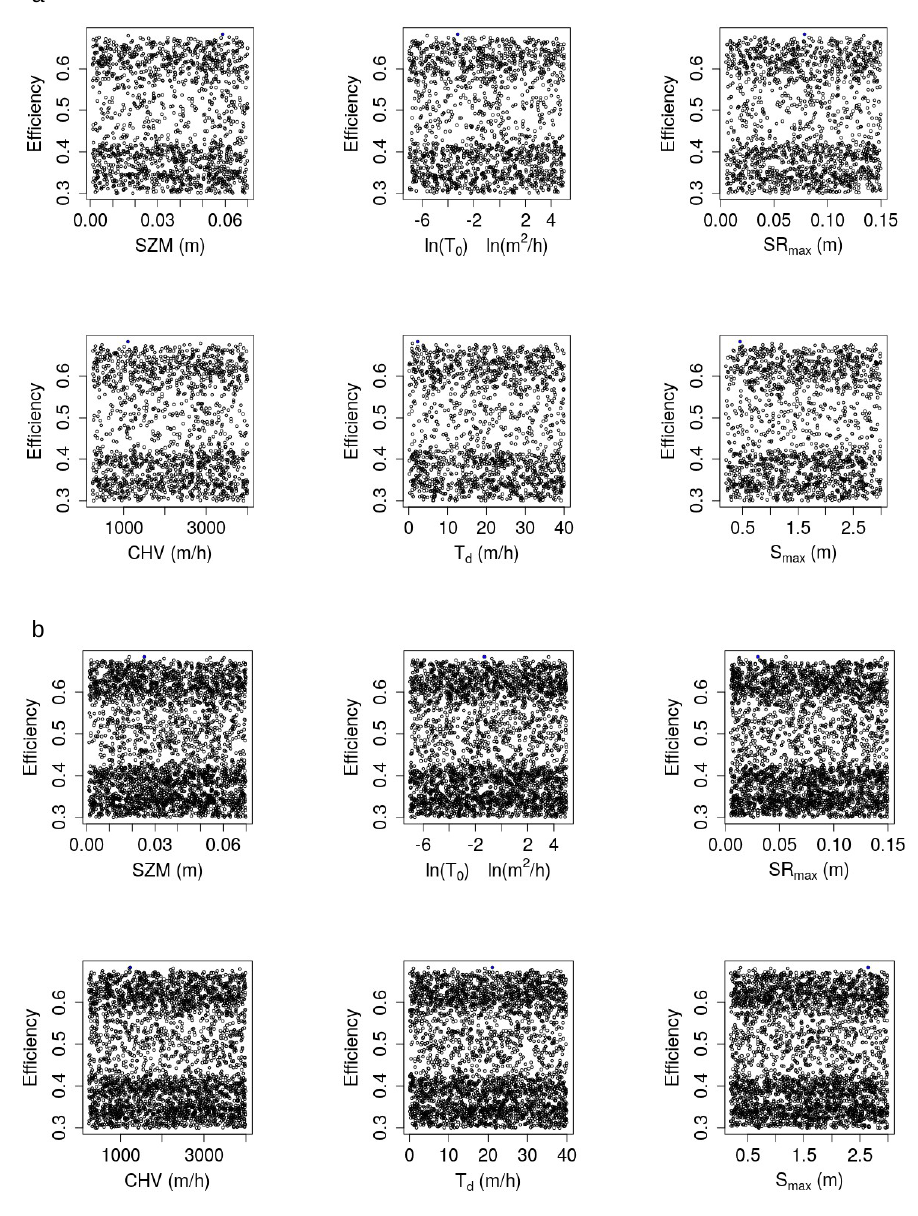
Figure 6. Scatter plot of efficiency versus behavioral parameters values for Peak 1 ( a ) 5000 simulations, ( b ) 10,000